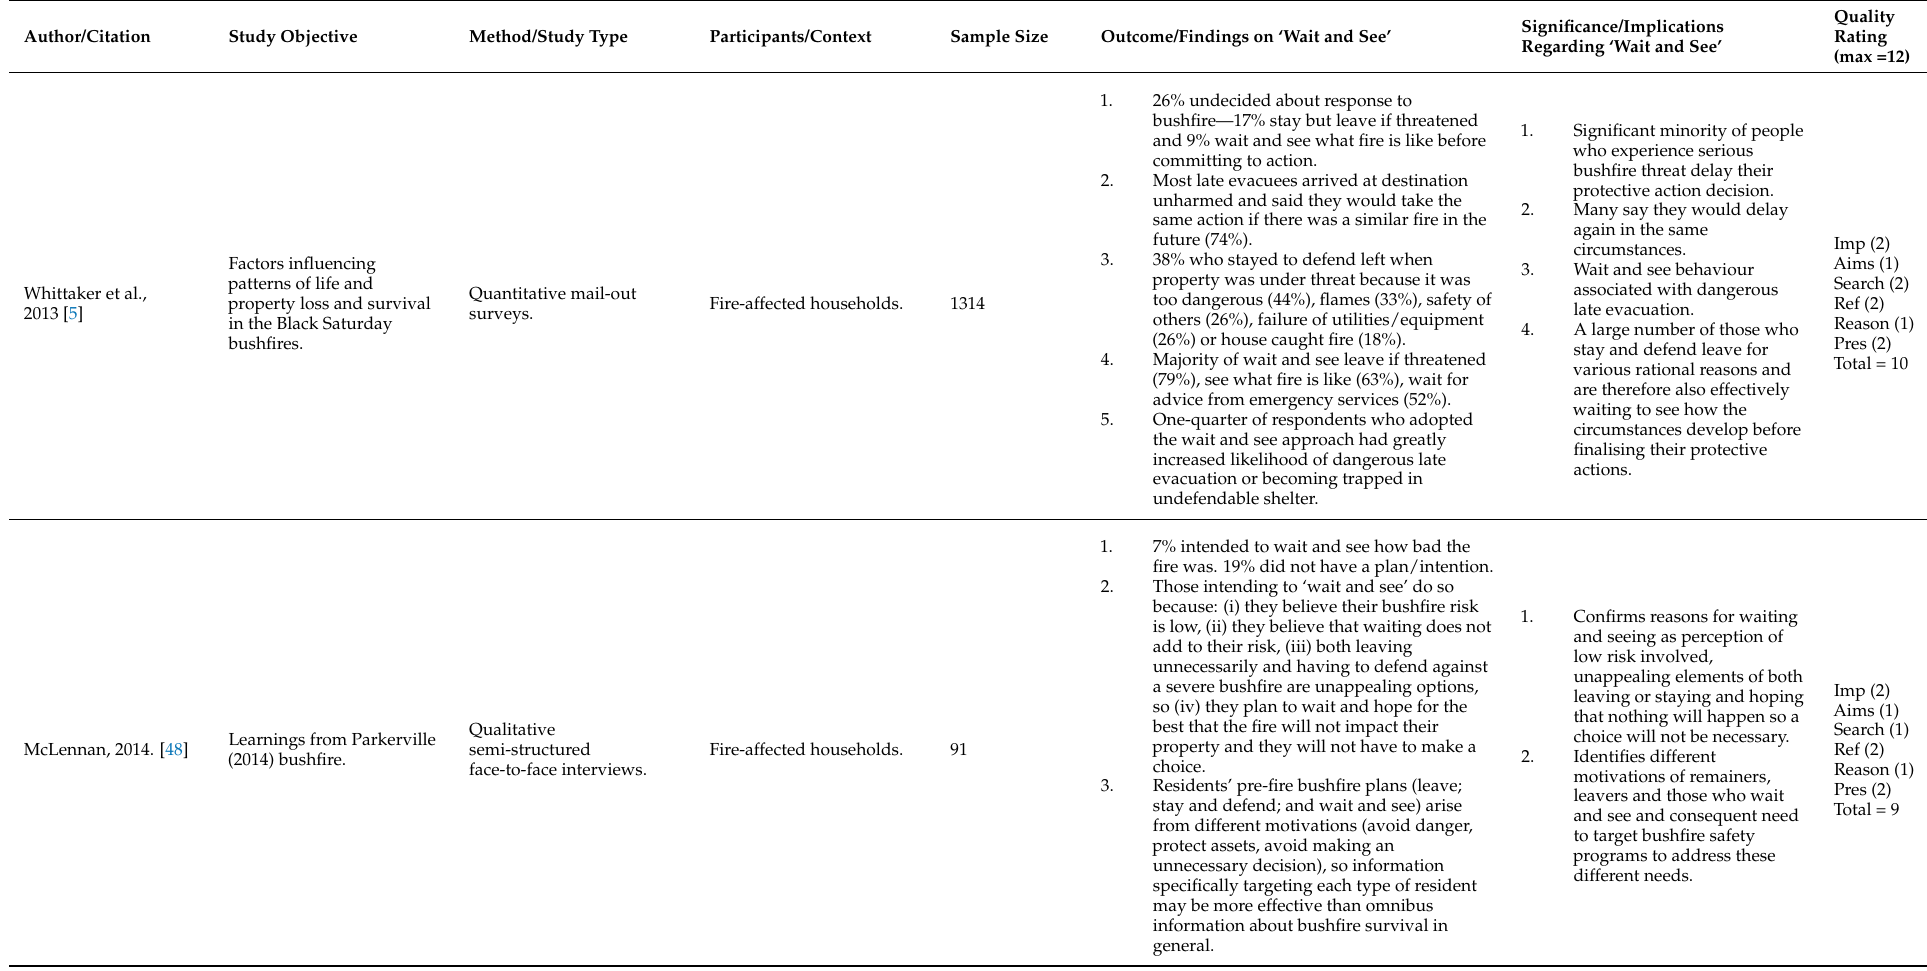
Table 2. Primary studies of wait and see in bushfire (or